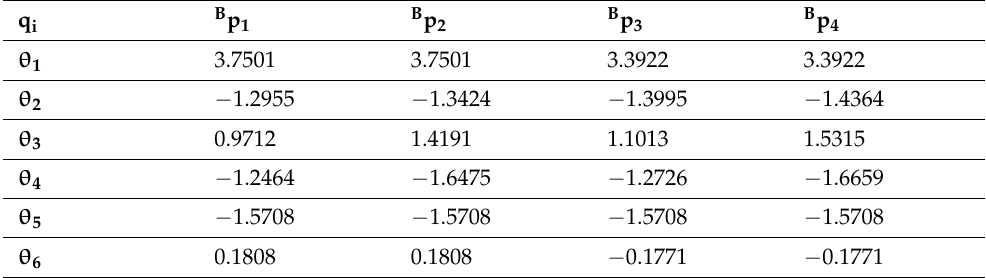
Table 2. Optimal location (joint variables values) for the pick and place task (cylindrical object).